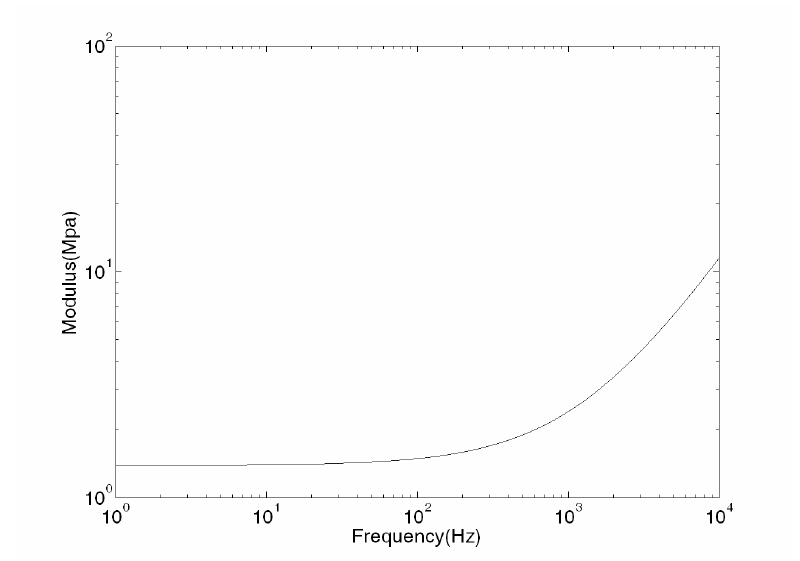
Fig. 8. The frequency-dependent amplitude of shear